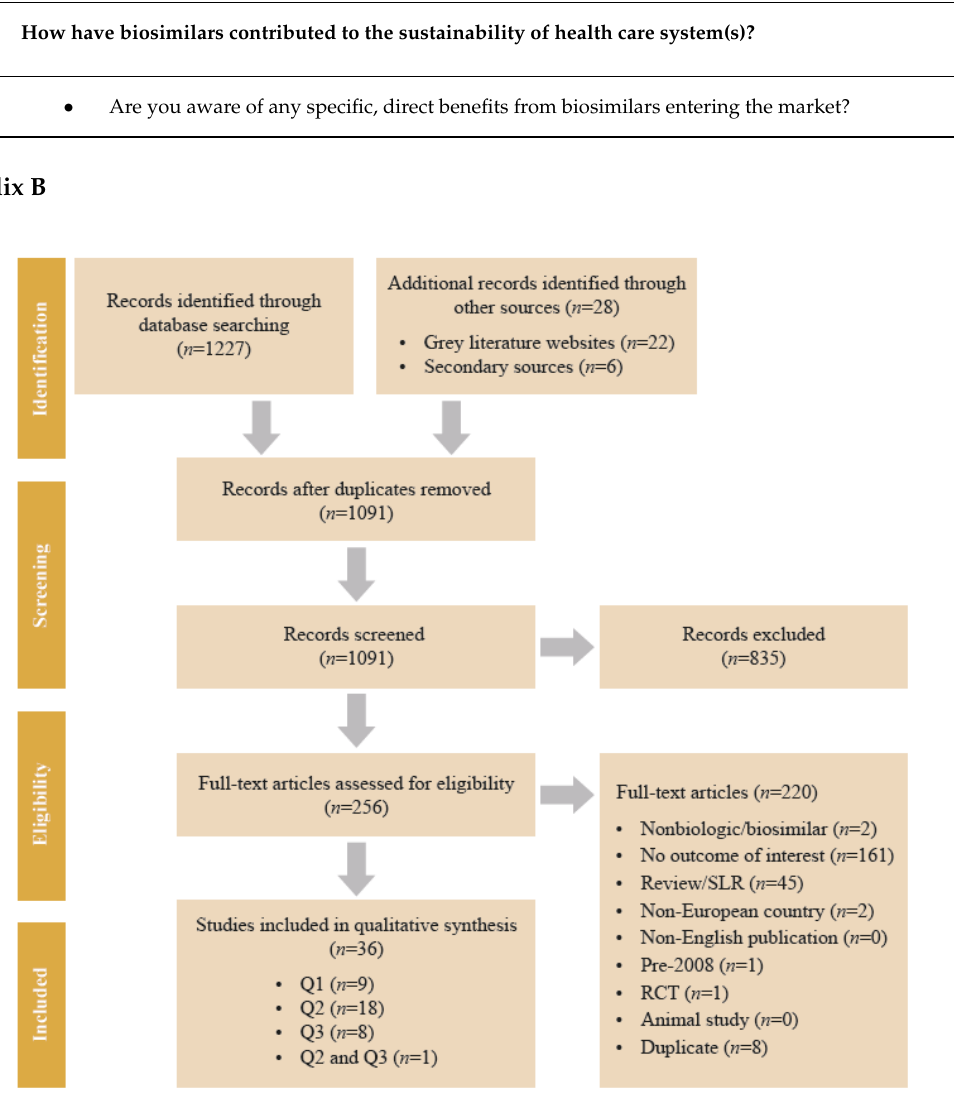
Table A2. Key literature identified during brainstorming (Delphi process stage 1).